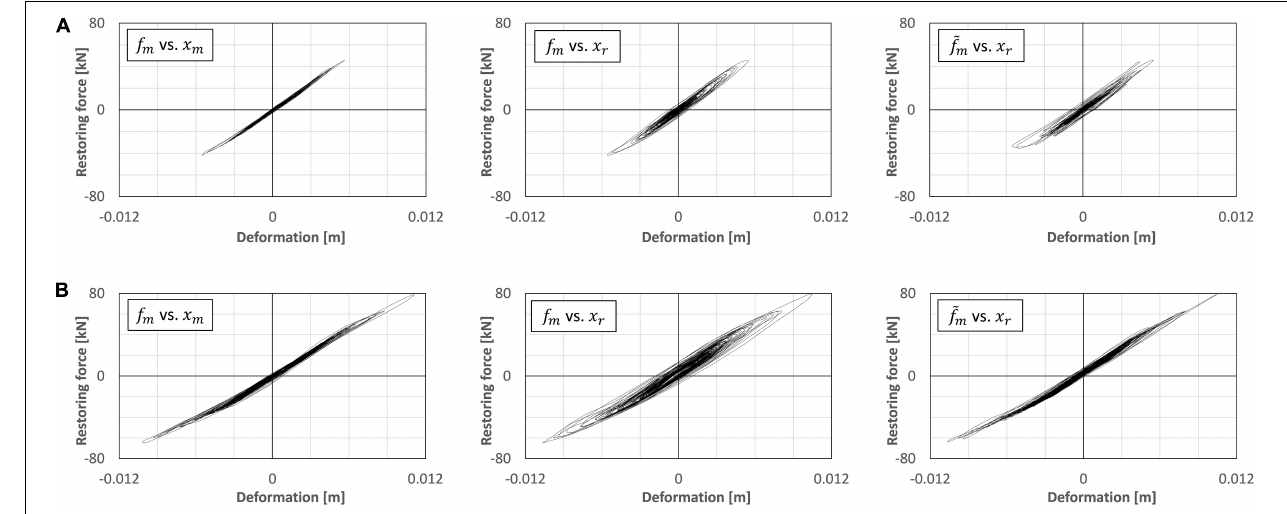
FIGURE 8 | Hysteresis of restoring force vs. deformation of RC column specimen. (A) f c = 0.5 Hz. (B) f c = 0.2 Hz.